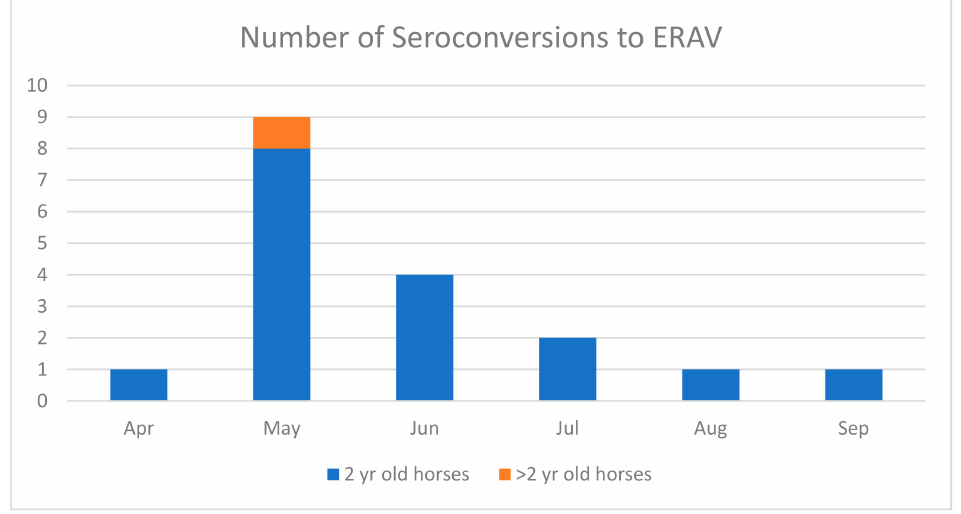
Figure 1. The number of horses that seroconverted to equine rhinitis A virus (ERAV) each month during the study period (April to